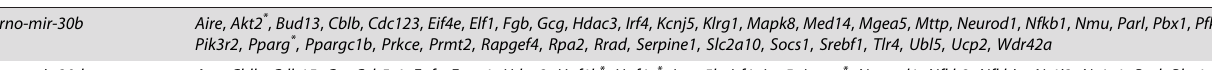
Table 3. Targets of rno-mir-30b and rno-mir-30d in T2D-related genes.